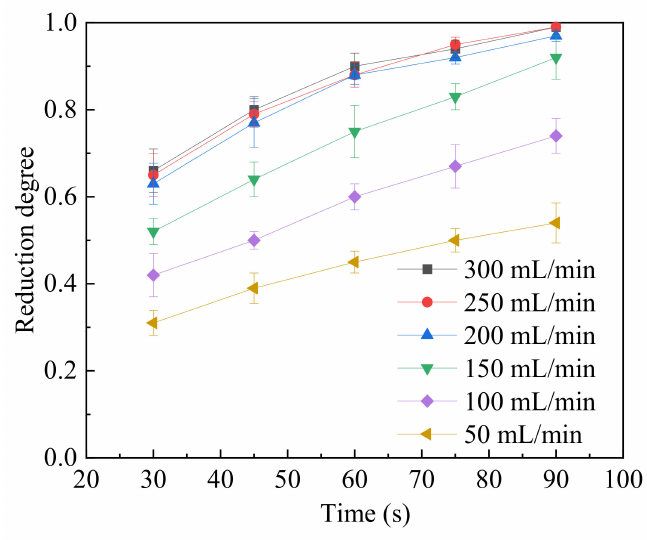
Figure 7. The relationship between the reduction degree and reduction time under different gas flowrates.